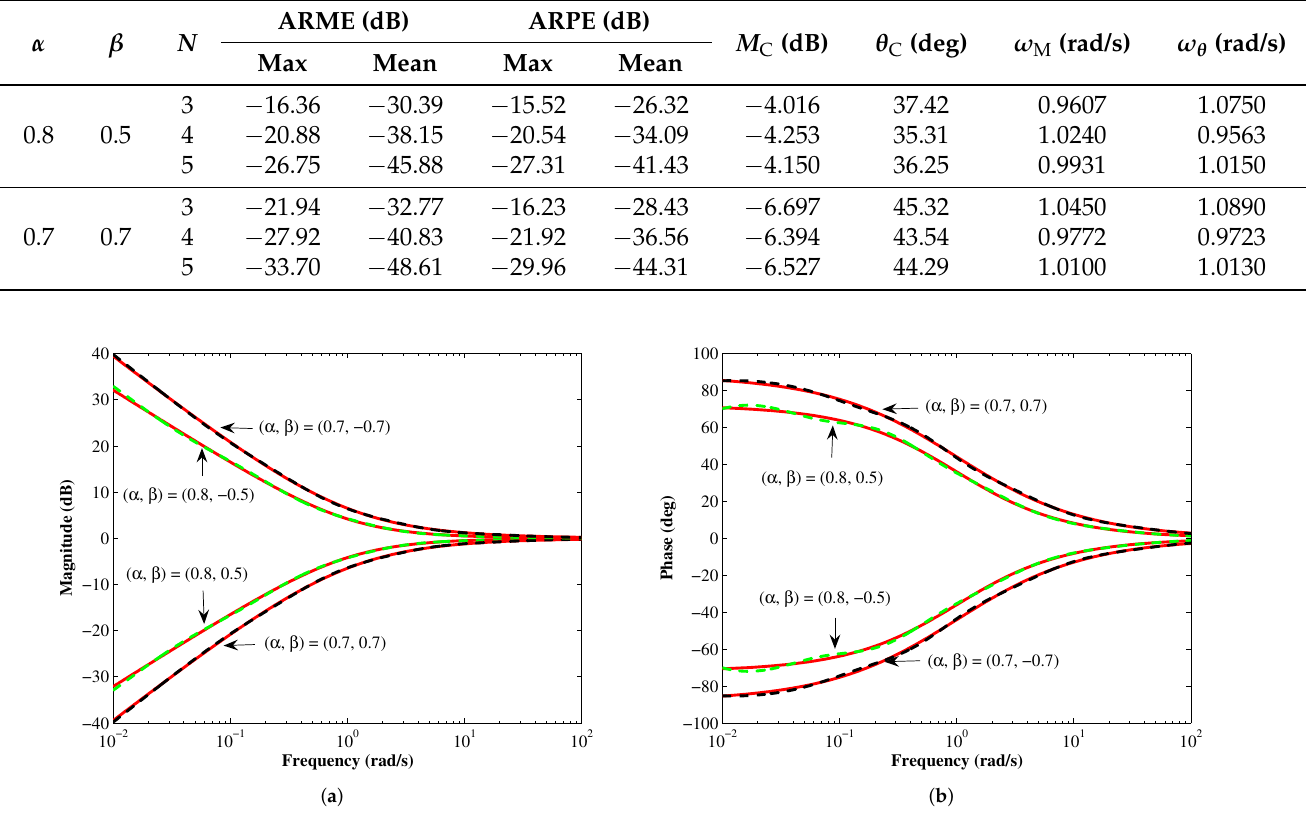
Figure 6. ( a ) Magnitude and ( b ) phase responses of the proposed FHPFs and FIHPFs for N = 4. The theoretical response is shown in solid